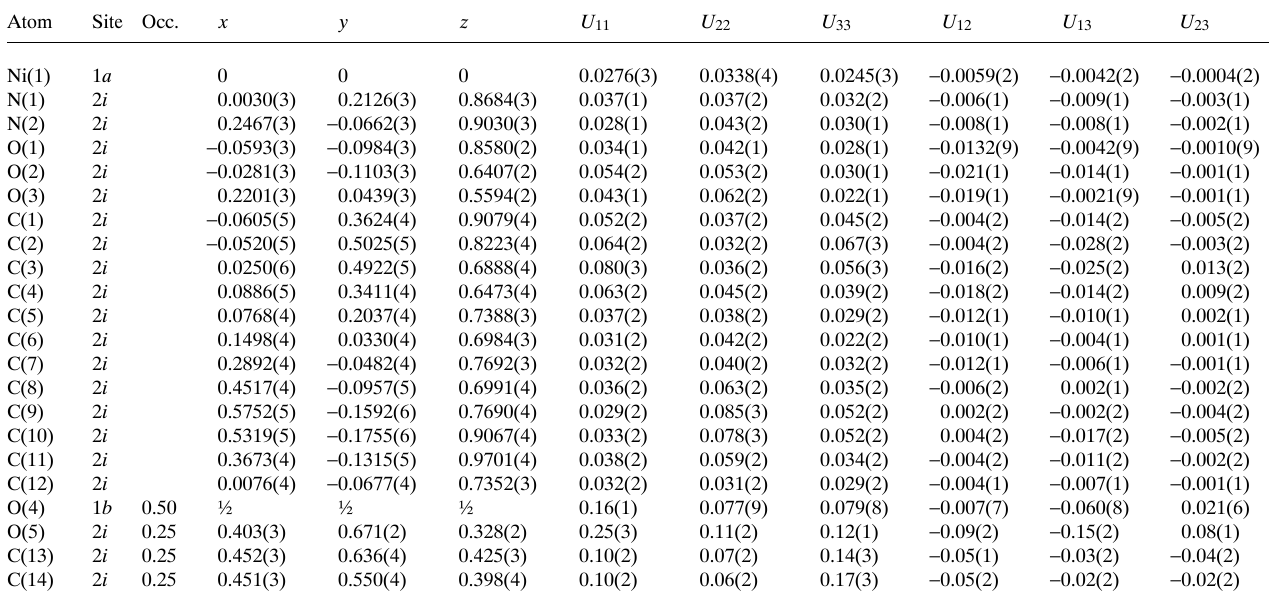
Table 3. A tomic coordin a tes a nd displ a cement p a r a meters (in Å 2 ) .